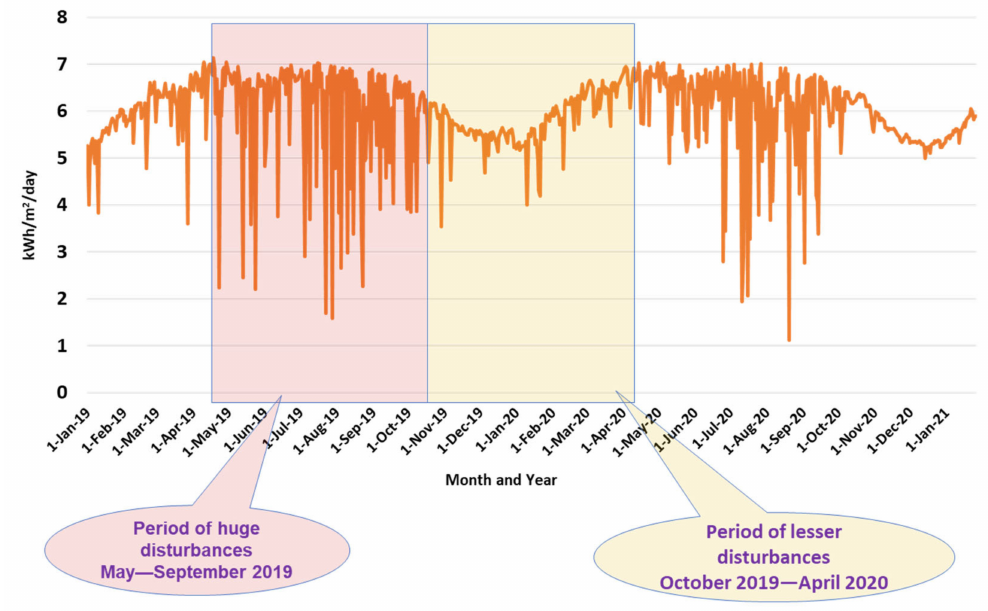
Figure 8. Solar radiation on the Essakane site from 2019 to